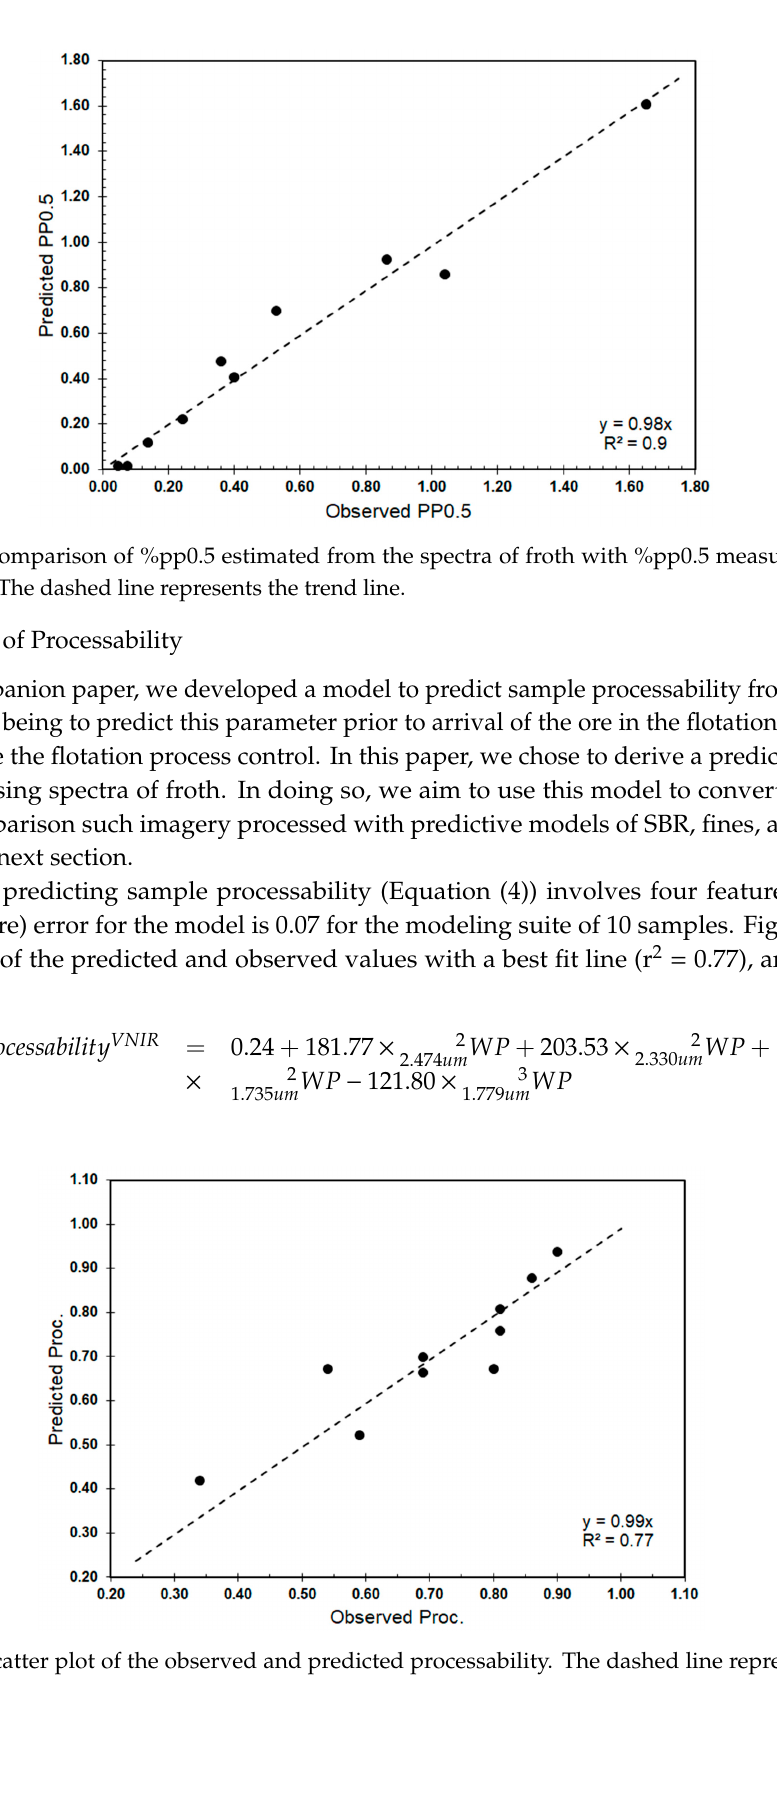
Figure 11. Comparison of %pp3.9 estimated from the spectra of froth with %pp3.9 measured from froth solids. The dashed line represents the trend line.